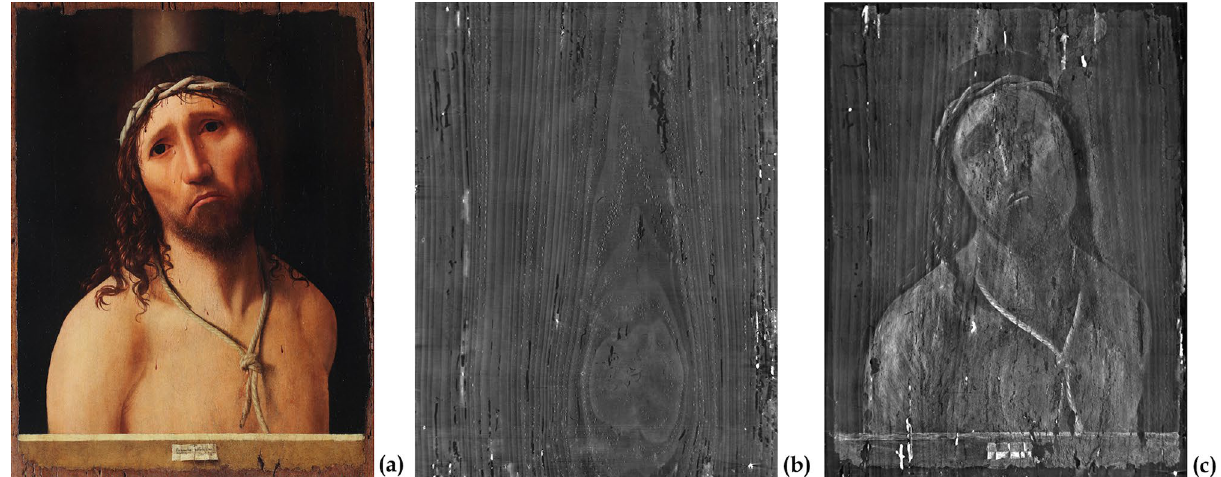
Figure 1. The Ecce Homo painting and its tomographic investigation. ( a ) Colorimetric calibrated image reconstructed from hyperspectral imaging (HSI) visible data. ( b ) Section of the tomographic volume related to the middle part of the board. ( c ) Sections of the tomographic volume related to the pictorial